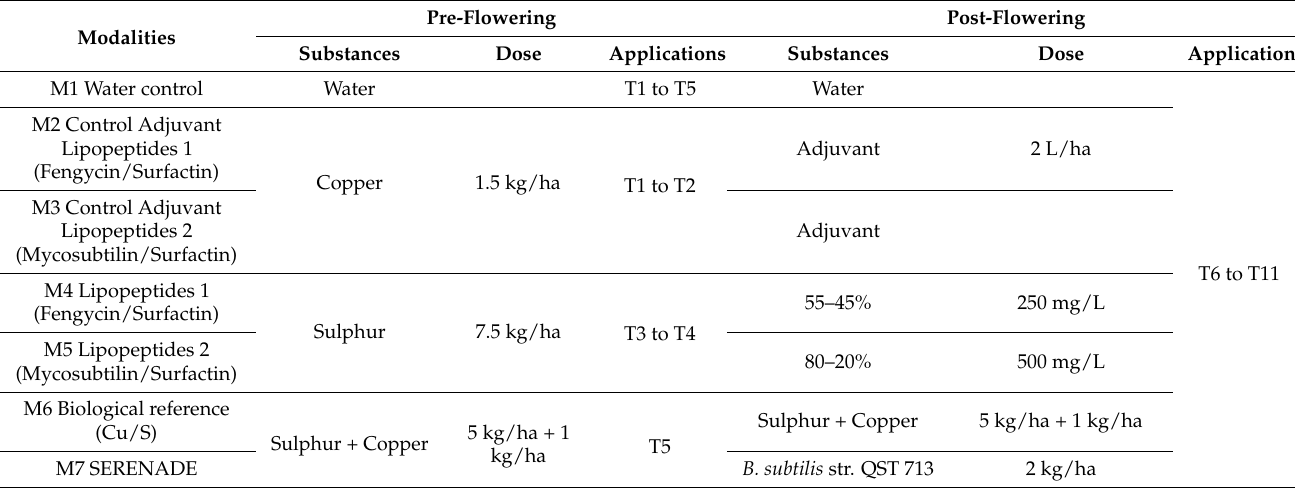
Table 2. Summary of the modalities studied against apple scab in